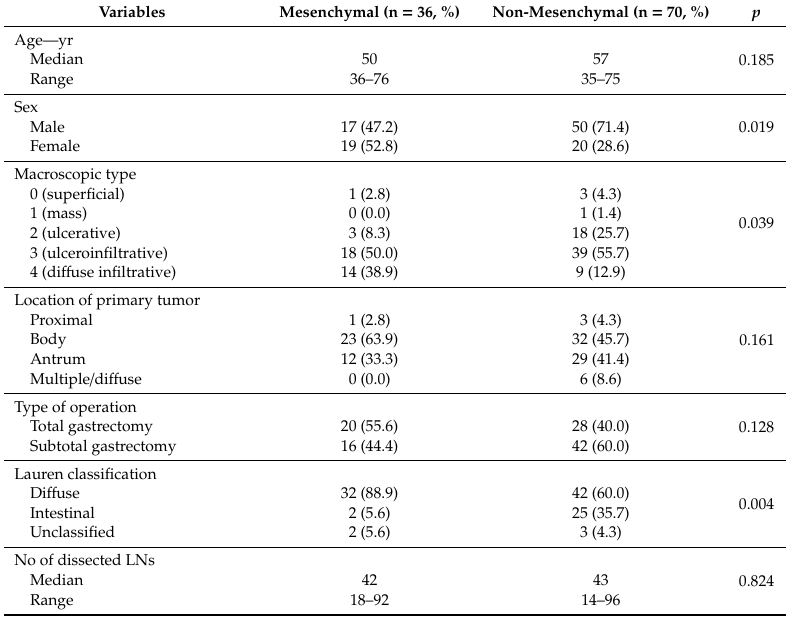
Table 1. Baseline characteristics of